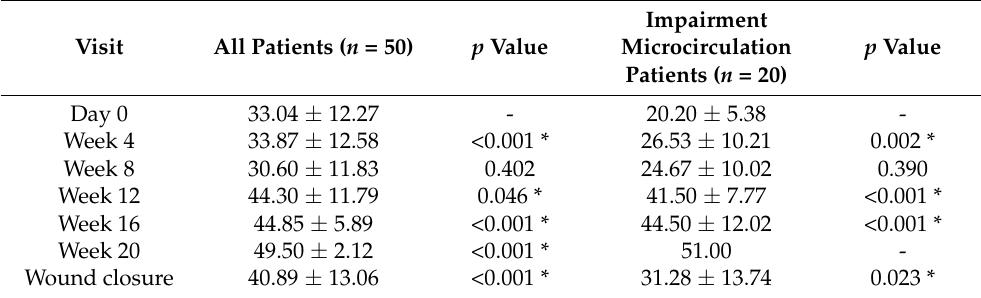
Table 3. Differences in tcpO 2 values in the feet of patients after sucrose octasulfate dressing applica- tion depending on microcirculation impairment (whole population and impaired microcirculation).